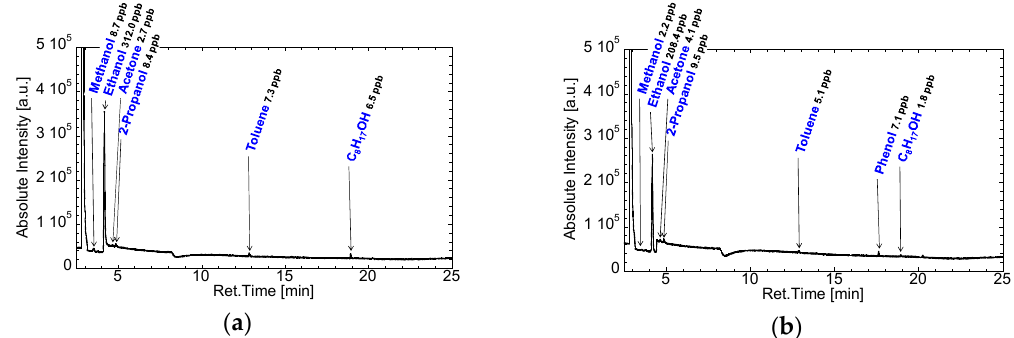
Figure 4. GC/MS spectra of the air of the consultation room in Aichi Cancer Center obtained using: an Analytic Barrier bag ( a ); and cleaned Tedlar bag ( b ).